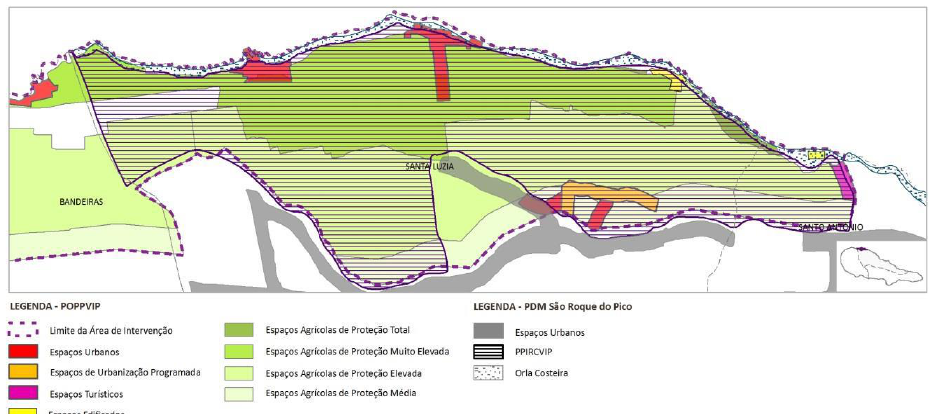
Figure 7. Cartography analysis between the special Protection Plan and the São Roque Municipal Plan. Source: Rocha (2013).